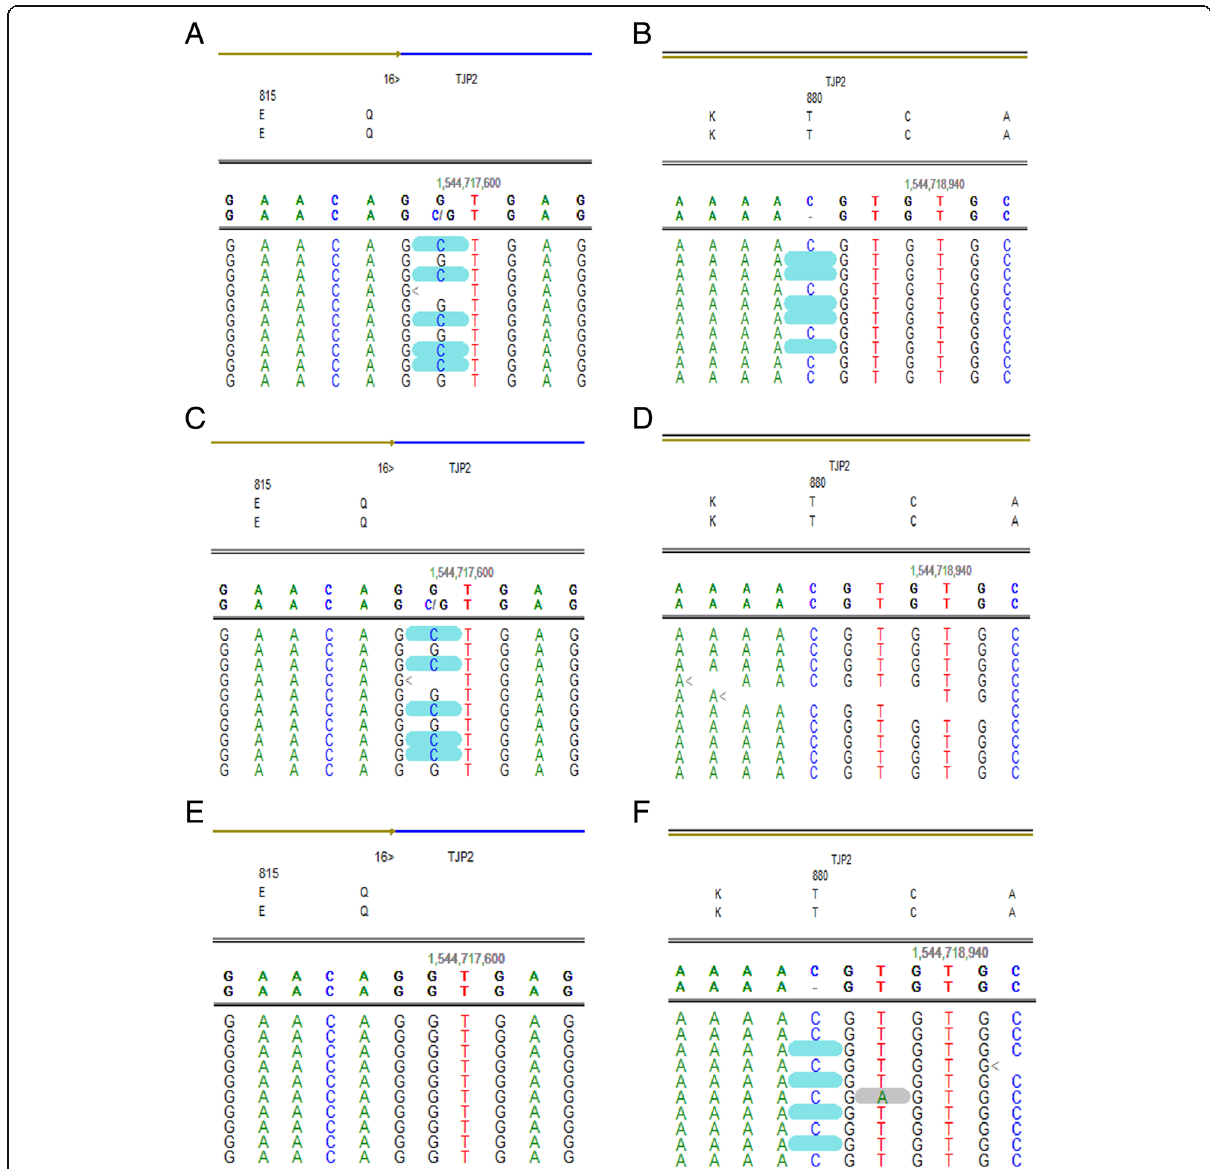
Fig. 1 TJP2 mutations analysis of the family. The proband carried compound heterozygous mutations c.2448 + 1G > C/c.2639delC (p.T880Sfs*12) of TJP2 ( a , b ), c.2448 + 1G > C inherited from her mother ( c , d ), and c.2639delC (p.T880Sfs*12) from her father ( e , f